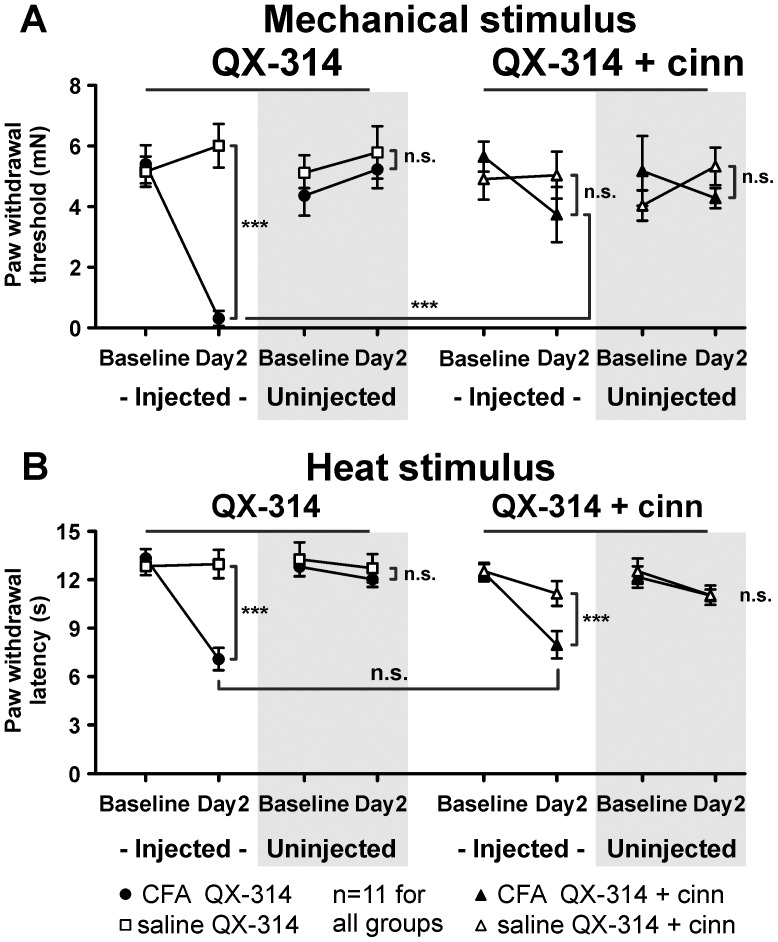
TRPA1-expressing fibers drive behavioral mechanical hyperalgesia.Treatment groups were divided into CFA-QX-314, saline-QX-314, CFA-QX-314+cinnamaldehyde (cinn) and saline-QX-314+cinn (concentrations were 0.2% QX and 30 µM cinn). A, Mechanical paw withdrawal threshold for each group in the injected paw (white) and uninjected paw (grey). B, Thermal paw withdrawal latency for each group in the injected paw (white) and uninjected paw (grey). *, two-way ANOVA followed by a Bonferroni post-hoc test of all four groups.